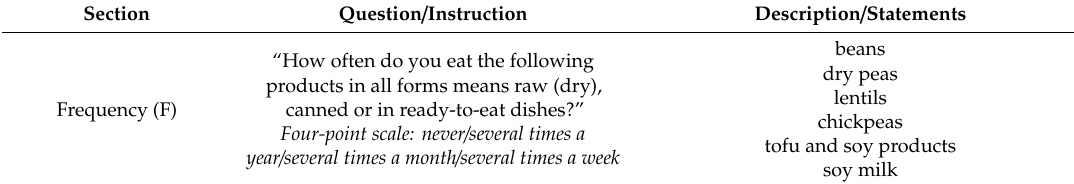
Table A1. Questionnaire